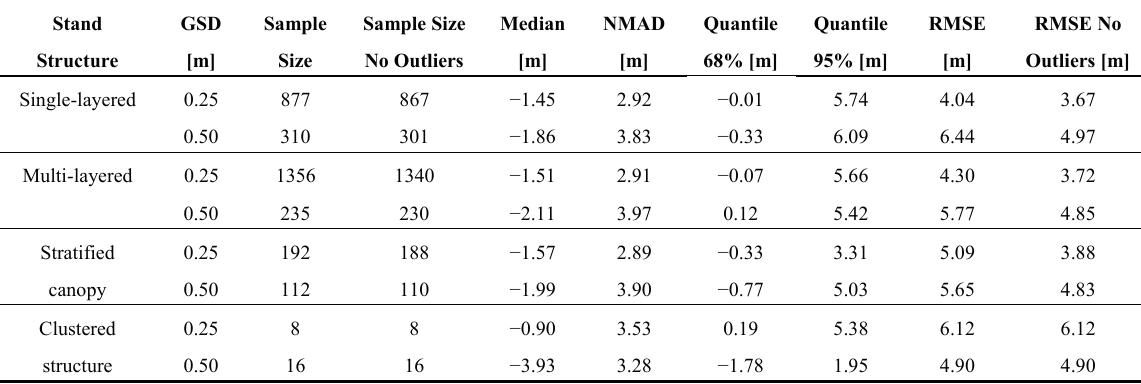
Table A7. Agreement of canopy height calculated from the CHM with the terrestrially measured canopy height according to stand structure. A threshold value of ±3 × RMSE was applied for outlier exclusion.